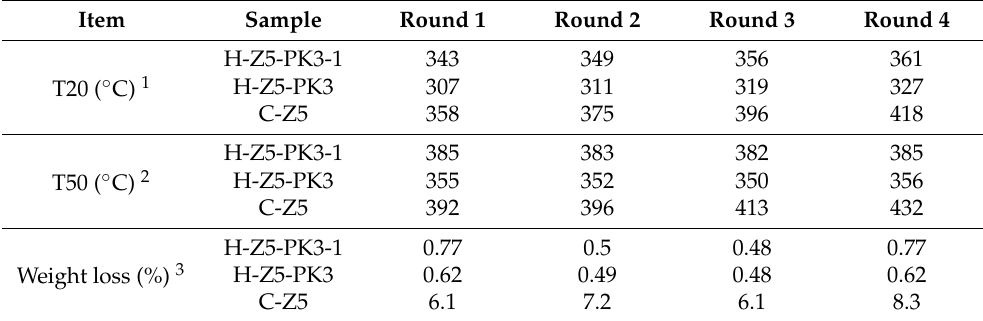
Table 3. Catalytic performance of the different ZSM-5 zeolites for LDPE cracking.